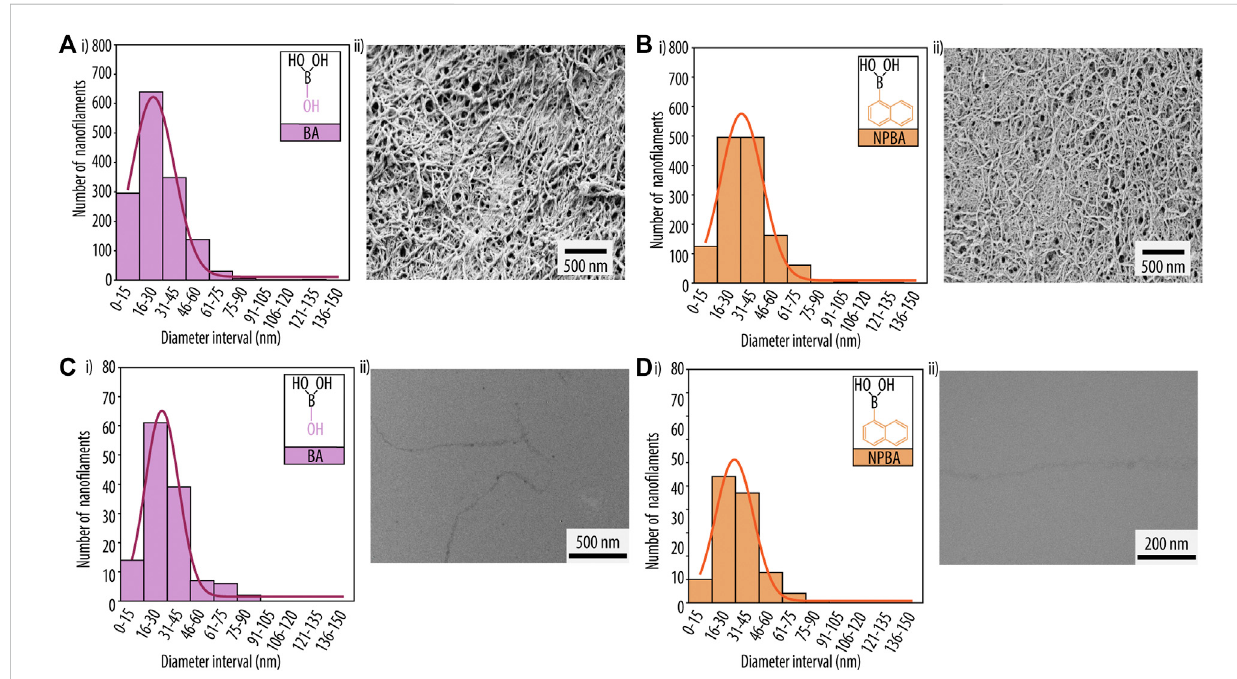
FIGURE 7 Scanning electron microscopy (SEM) analysis of printed hydrogels for guanosine (Guo)-based hydrogels using (A) boric acid (BA) and (B) 2- naphtylboronicacid(NPBA).(i)Diameterdistributionhistogramsofthenano fi brillarnetworkand(ii)SEMimages.Transmissionelectronmicroscopy(TEM) analysis for (C) Guo-BA hydrogels and (D) Guo-NPBA hydrogels. (i) Diameter distribution histograms of the nano fi brillar network and (ii) TEM image.